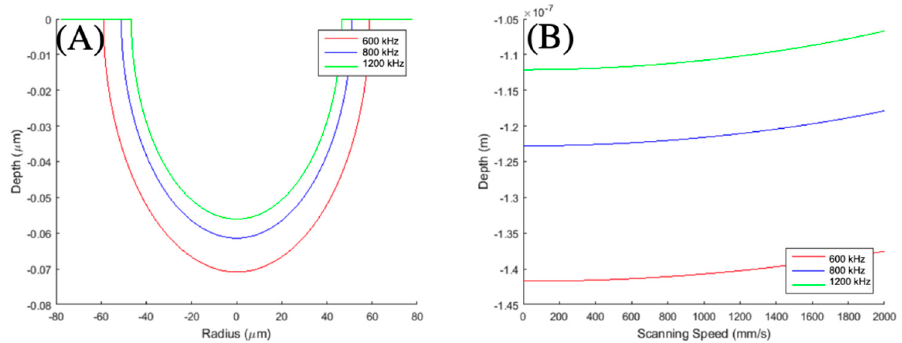
Figure 6. ( A ) Theoretical ablation depth profile as a function of radius and ( B ) theoretical ablation depth profile as a function of laser scanning speed for single pulsed laser with frequency of 600, 800 and 1200 kHz.